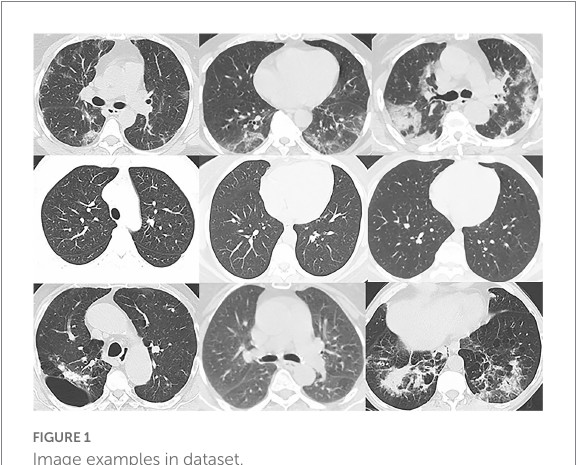
FIGURE 1 Image examples in